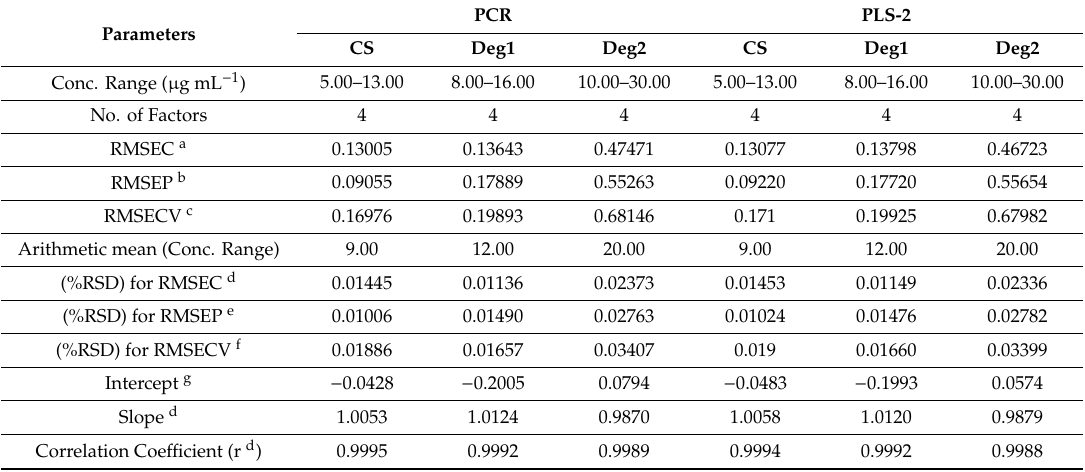
Table 4. Statistical parameters for simultaneous determination of CS, Deg1 and Deg2 using PCR and PLS-2.